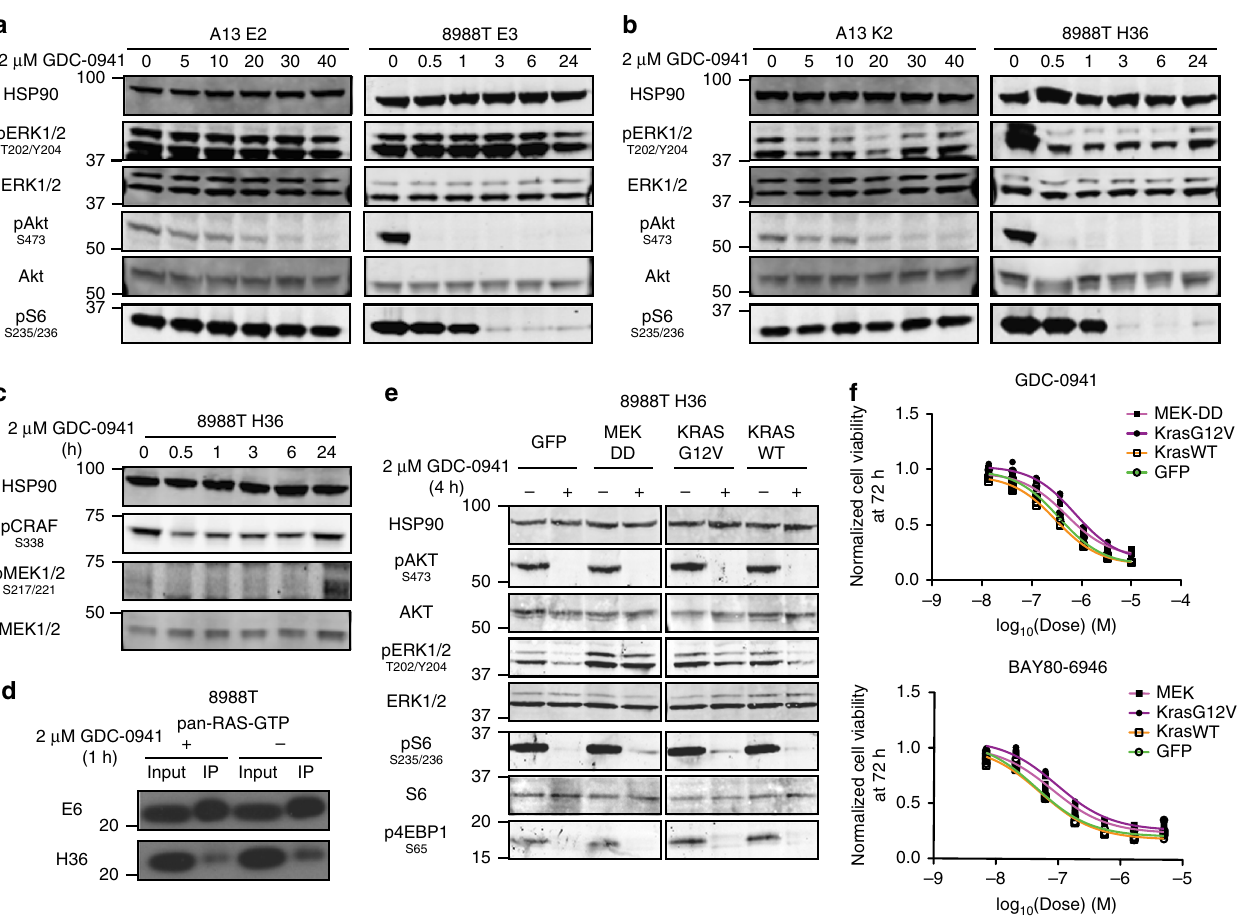
Fig. 5 MAPK blockade following PI3K inhibition in KRAS de fi cient cells. a Western blot showed no change in pERK1/2 levels in KRAS intact cells at designated times (minutes for A13, hours for 8988T) following GDC-0941 treatment. HSP90 is loading control. b Western blot demonstrated a transient decrease in pERK1/2 levels in KRAS de fi cient cells at designated times (minutes for A13, hours for 8988T) following GDC-0941 treatment. c Western blot showed a transient decrease in phosphorylation of the MAPK pathway regulators CRAF and MEK1/2 following GDC-0941 treatment in KRAS de fi cient cells. d Western blot of RAS-GTP levels in KRAS intact (E6) and de fi cient (H36) clones following 1-h treatment with GDC-0941 showed a speci fi c decline in de fi cient cells. e Overexpression of constitutively active MEK ( MEK-DD ) or oncogenic KRAS - G12V , but not KRAS-WT or GFP , blocked pERK1/2 inhibition by a 4-h treatment with GDC-0941. f MEK-DD and KRAS-G12V -transduced cells from e showed decreased sensitivity to PI3K inhibition compared to control